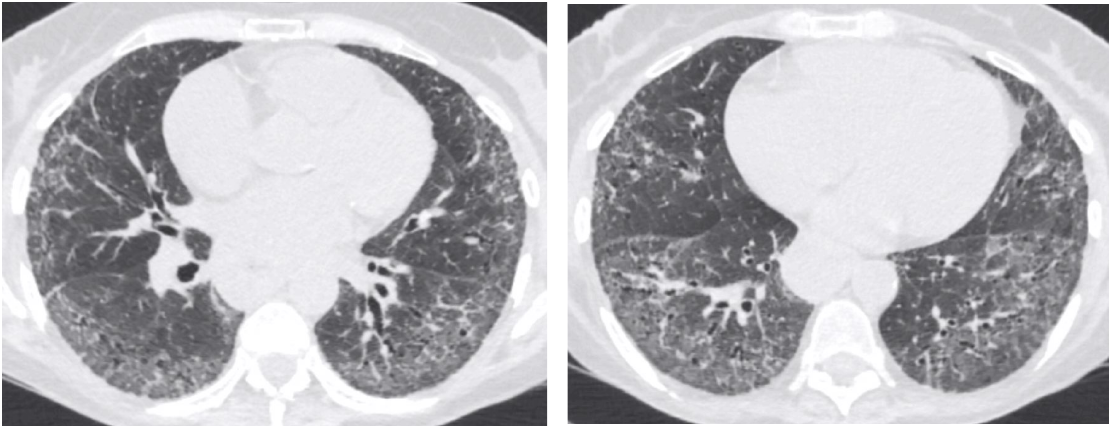
Figure 2. CT of the thorax—lung window—showing bilateral fine interstitial thickening and ground glass opacities with a basal predominance, minimal traction bronchiectasis and relative subpleural sparing (NSIP pattern).